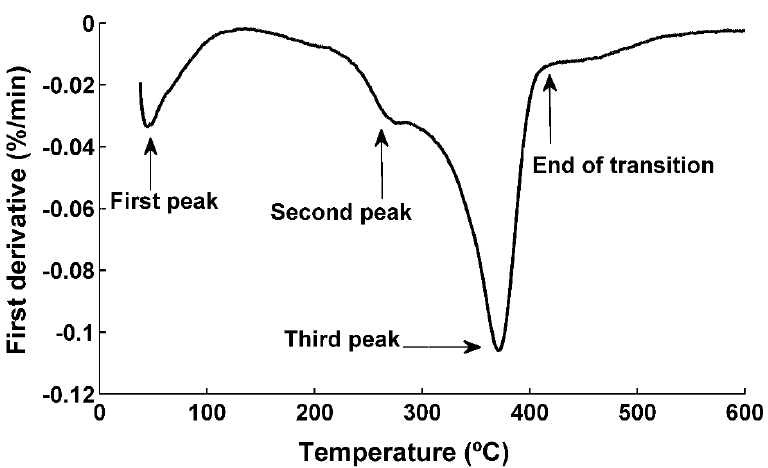
Figure 4. Cellulose content and percentage crystallinity as function of dpa for TX55 genotype.